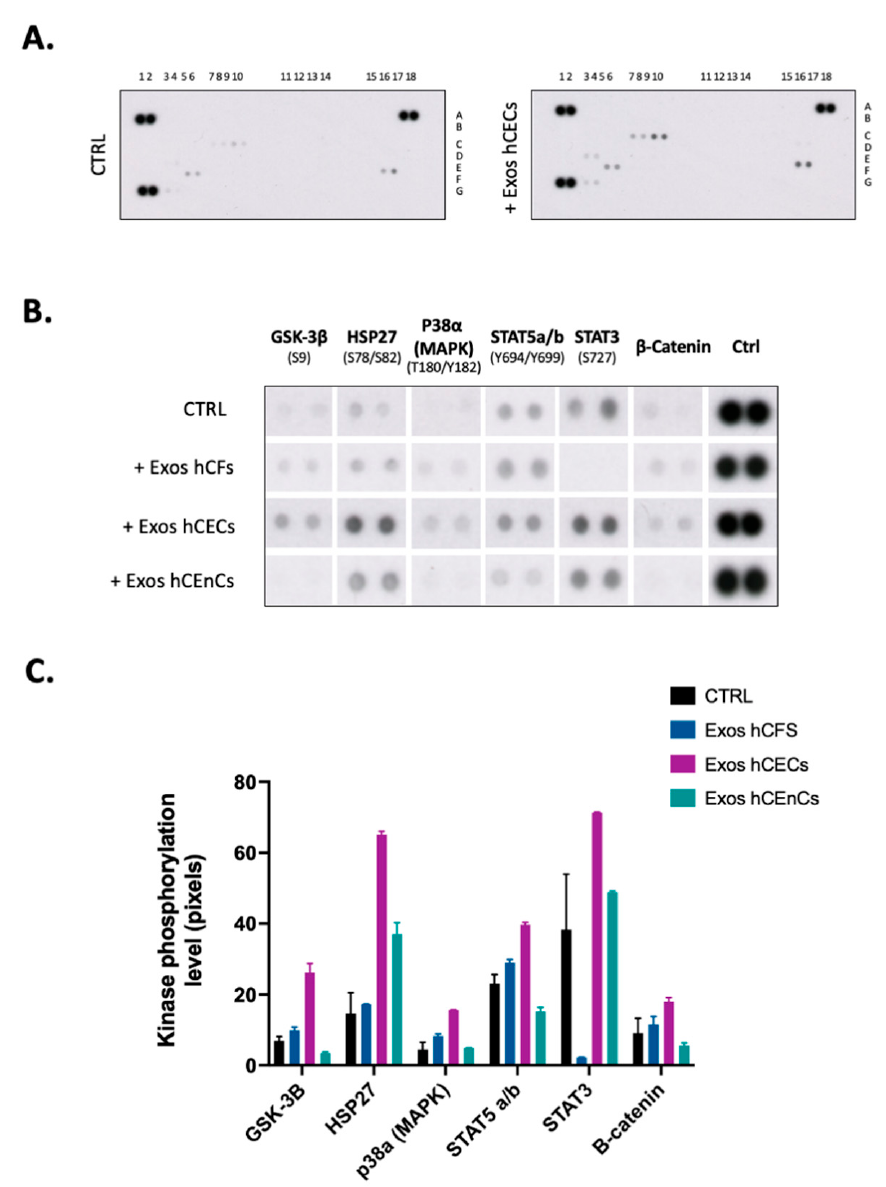
Figure 5. Impact of the exosomes isolated from the different corneal cell types on the phosphorylation of signal transduction mediators in hCECs. ( A ) Cells were cultured 48 h with hCFs-, hCECs-, hCEnCs-exosomes or the vehicle (HBS). Cell lysates prepared from hCECs were used as sources of proteins for the phosphokinase assays conducted as detailed in Section 4. The results obtained for hCECs exposed solely to the vehicle (HBS) or to hCECs exosomes are shown as examples. ( B ) Duplicate spots corresponding to the kinases (GSK-3 β , p38 α (MAPK), STAT5a/b, STAT3, β -catenin) whose phosphorylation is the most altered in monolayer-cultured hCECs after the addition of exosomes from hCECs, HCFs or hCEnCs. hCECs exposed only to the vehicle were used as negative control (CTRL). ( C ) The phosphorylation level (in pixels) for each spot was determined with the ImageJ Software and plotted on graph. One of two representative experiments conducted using two distinct populations of hCECs is shown.